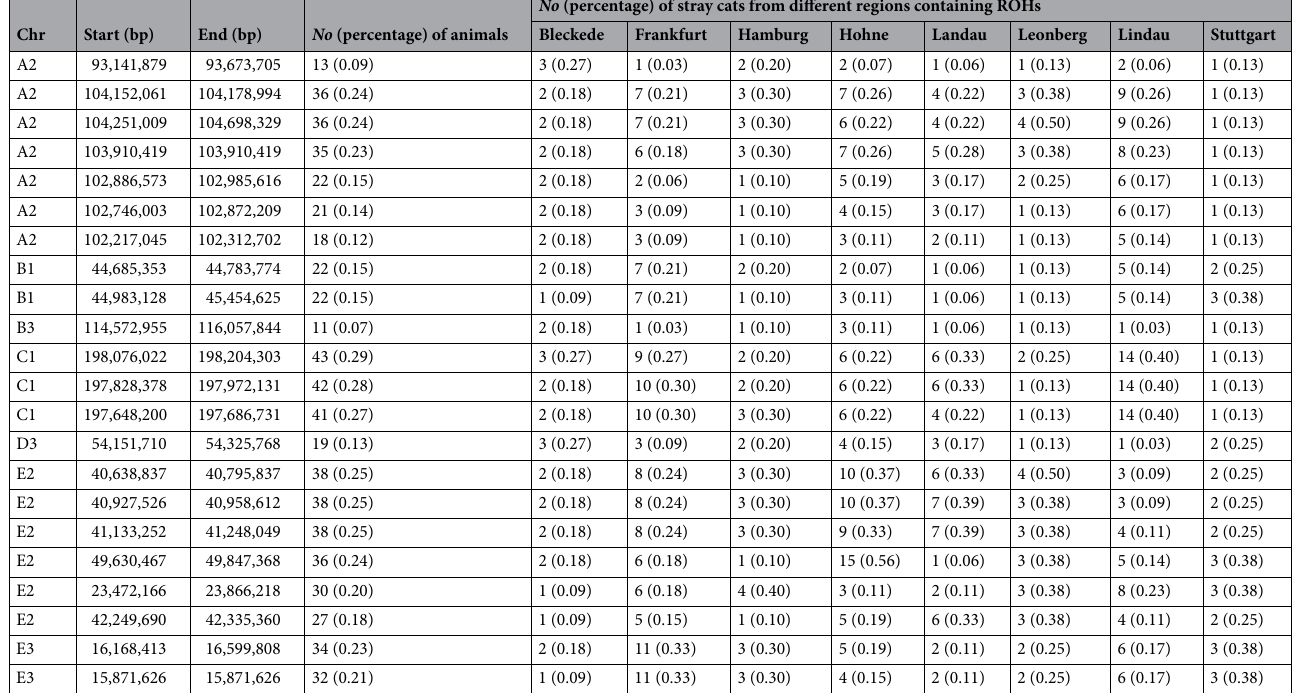
Table 5. Partial consensus ROHs shared by stray cats from eight different residential regions. Given are the chromosomal location, total number (and percentage) of stray cats containing ROHs, and the distribution (number and percentage) of animals among the different regions.